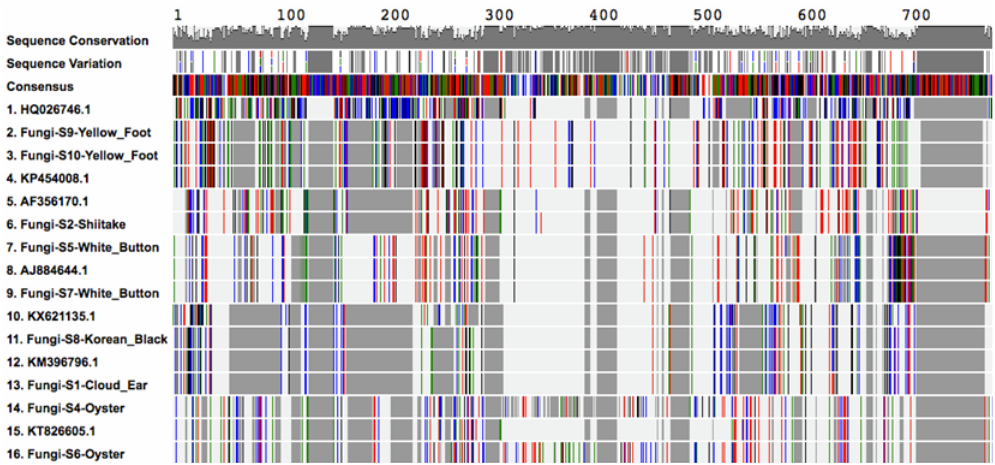
Figure 1. Sample consensus sequences (S1–S10) aligned with corresponding Basic Local Alignment Search Tool nucleotide search (BLASTn) sequences hits and one Aspergillus fumigatus sequence, using the MUSCLE multiple alignment software embedded in DNA Subway to create a visual DNA barcode. Sequence lengths are indicated as numbers on the top, and the sequence conservation and variation values are indicated as grey bars in the top three panels. Nucleotides are color coded with green representing A, red representing T, black repenting G, and blue representing C. The columns are matches (or mismatches) at a single nucleotide position across all of the sequences in comparison to the consensus sequence. This ‘Alignment Viewer’ allows citizen scientists to quickly screen for samples generating similar or identical barcodes, indicating that they are closely related or the same